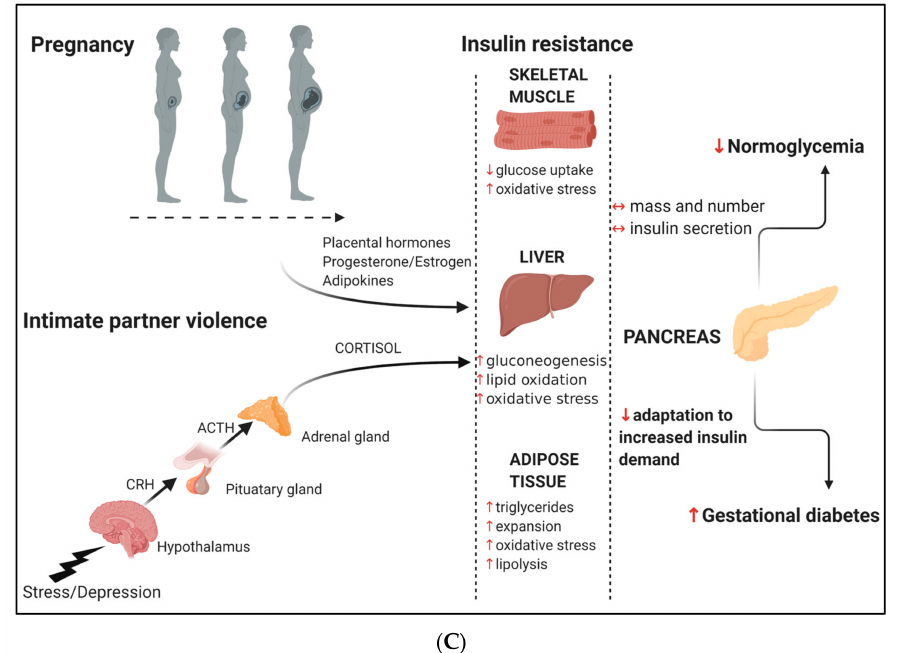
Figure 1. The e ff ect of pregnancy and intimate partner violence (IPV) on the development of gestational diabetes mellitus (GDM). ( A ). Pregnancy-induced insulin resistance leads to the development of GDM in women who are not able to mount a compensatory β -cell response. ( B ). IPV-induced stress and depression leads to insulin resistance and an increased GDM risk. ( C ). Pregnancy- and IPV-induced insulin resistance that occur concurrently decreases the compensatory ability of pancreatic beta cells to increase insulin production and secretion, leading to an increased risk of developing